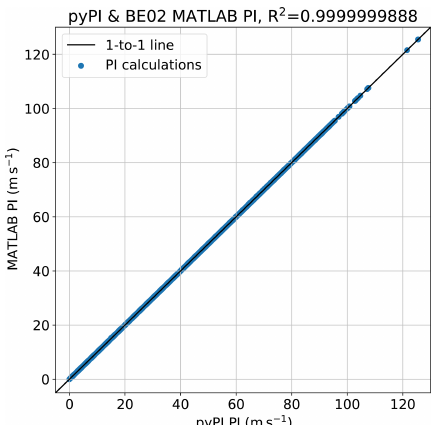
Figure 5. 2004 mean potential intensities (ms − 1 , blue dots) cal- culated with pyPI (horizontal axis) and the BE02 MATLAB code (vertical axis). The black curve is the 1:1